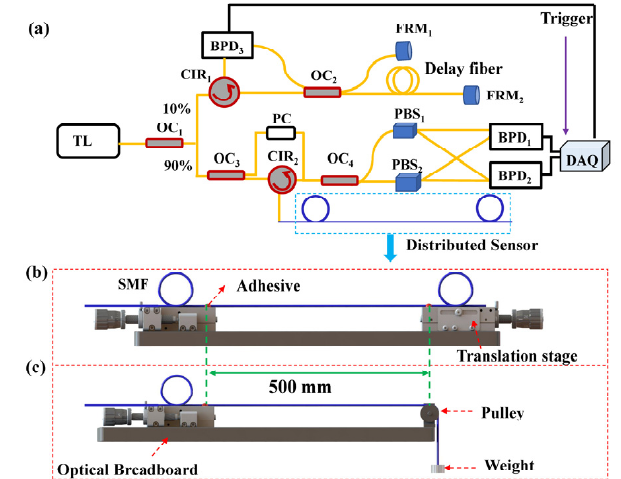
Figure 1. Experimental setup for measuring Young’s modulus of an optical fiber by use of ( a ) an optical frequency domain reflectometry (OFDR), in which a tensile strain is applied to the fiber by ( b ) a translation stage and ( c ) a weight, respectively. TL: tunable laser; OC: optical coupler; CIR: circulator; PC: polarization controller; PBS: polarization beam splitter; FRM: faraday rotating mirror; BPD: balanced photo-detector; DAQ: data acquisition card.